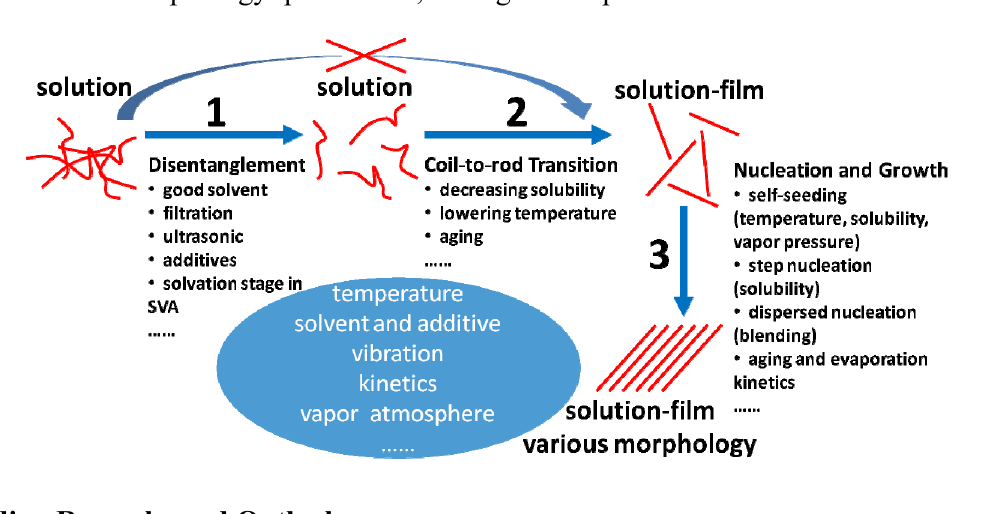
Figure 25. Schematic illustration of the control over solution state and casting films to obtain ordered morphology: procedures, strategies and